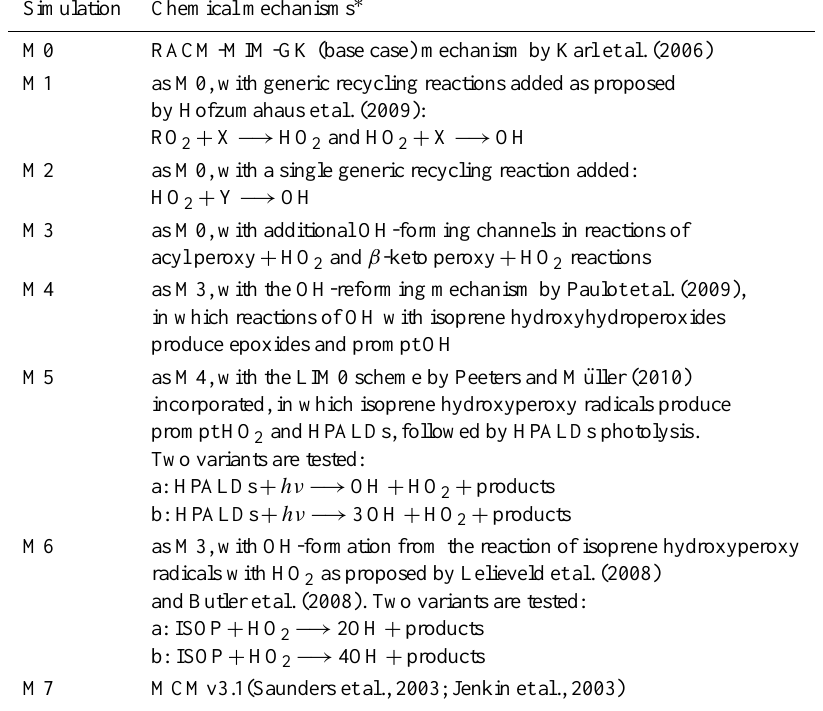
Table 5. Chemical mechanisms used in box model simulations of HO x for PRIDE-PRD2006.